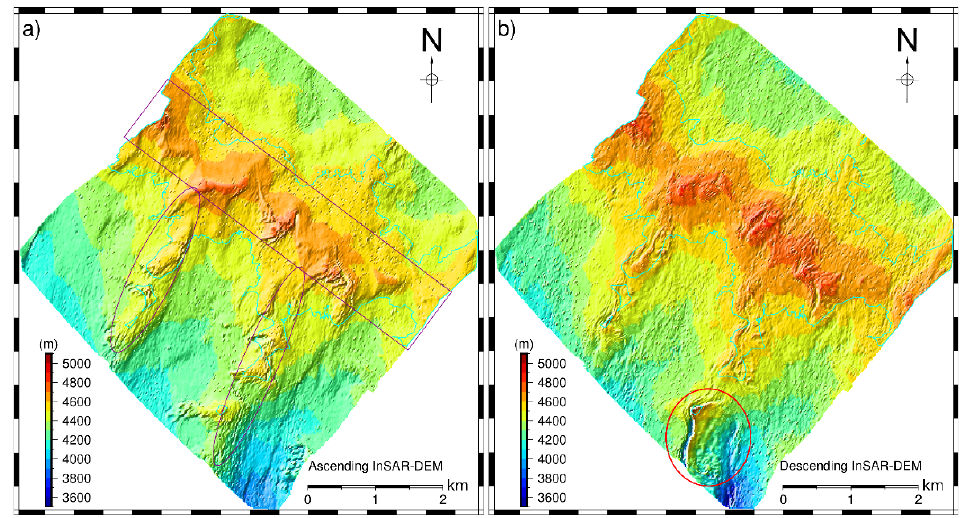
Figure 6. DEMs obtained from Sentinel-1a InSAR processing: ( a ) generated from Sentinel-1a ascend- ing data and ( b ) descending data. The location of the main mountain range is marked by the dark magenta rectangle, the two dark magenta ellipses represent the location of the two lower mountains, and the area inside and outside the irregular-shaped cyan polygon is the area with an elevation greater than or equal to 4500 m. The red circle in ( b ) indicates the region with large differences in DEM.